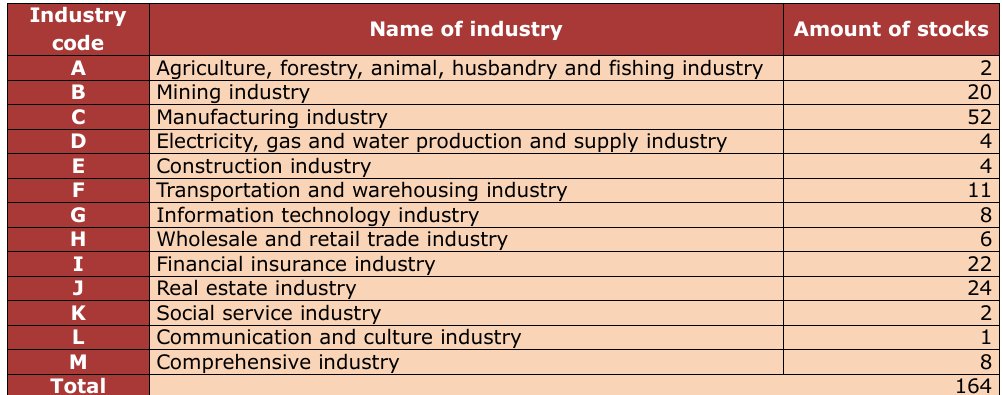
Table 1. Listing Corporation Industry Classification